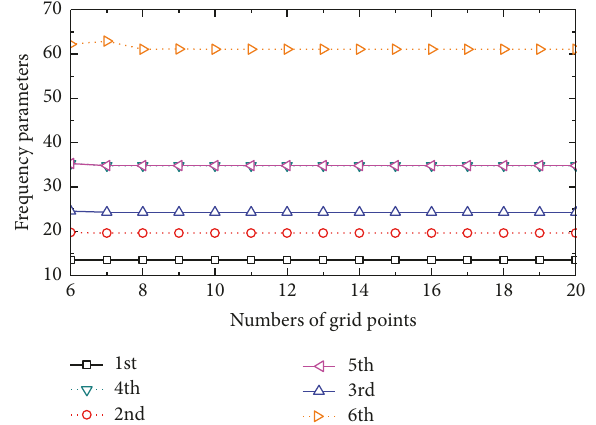
Figure 3: The first six frequency parameters of a square plate with different numbers of grid points.